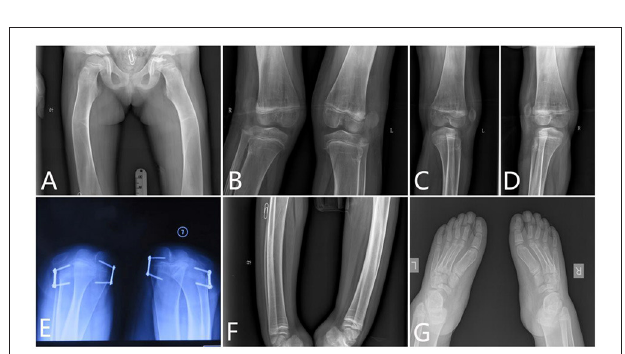
FIGURE 3 | The x-ray radiography of the hands [shows short and wide phalanges and deformable bones; (A) age 1 year and 5 months, (B) age 6 years and 8 months].